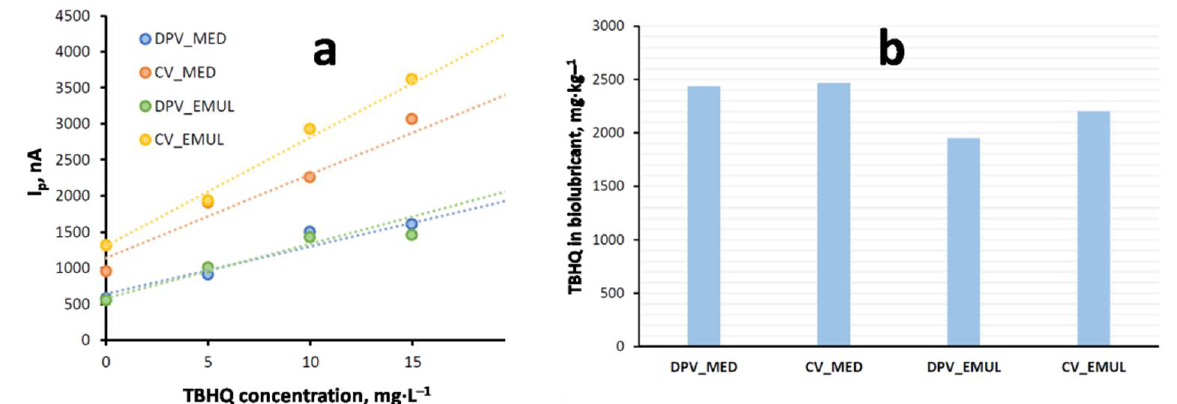
Figure 6. Differences between CV and DPV through emulsion medium (EMUL) and dispersive mi- croextraction (MED): ( a ) changes in intensity peak; ( b ) calculated TBHQ concentrations.